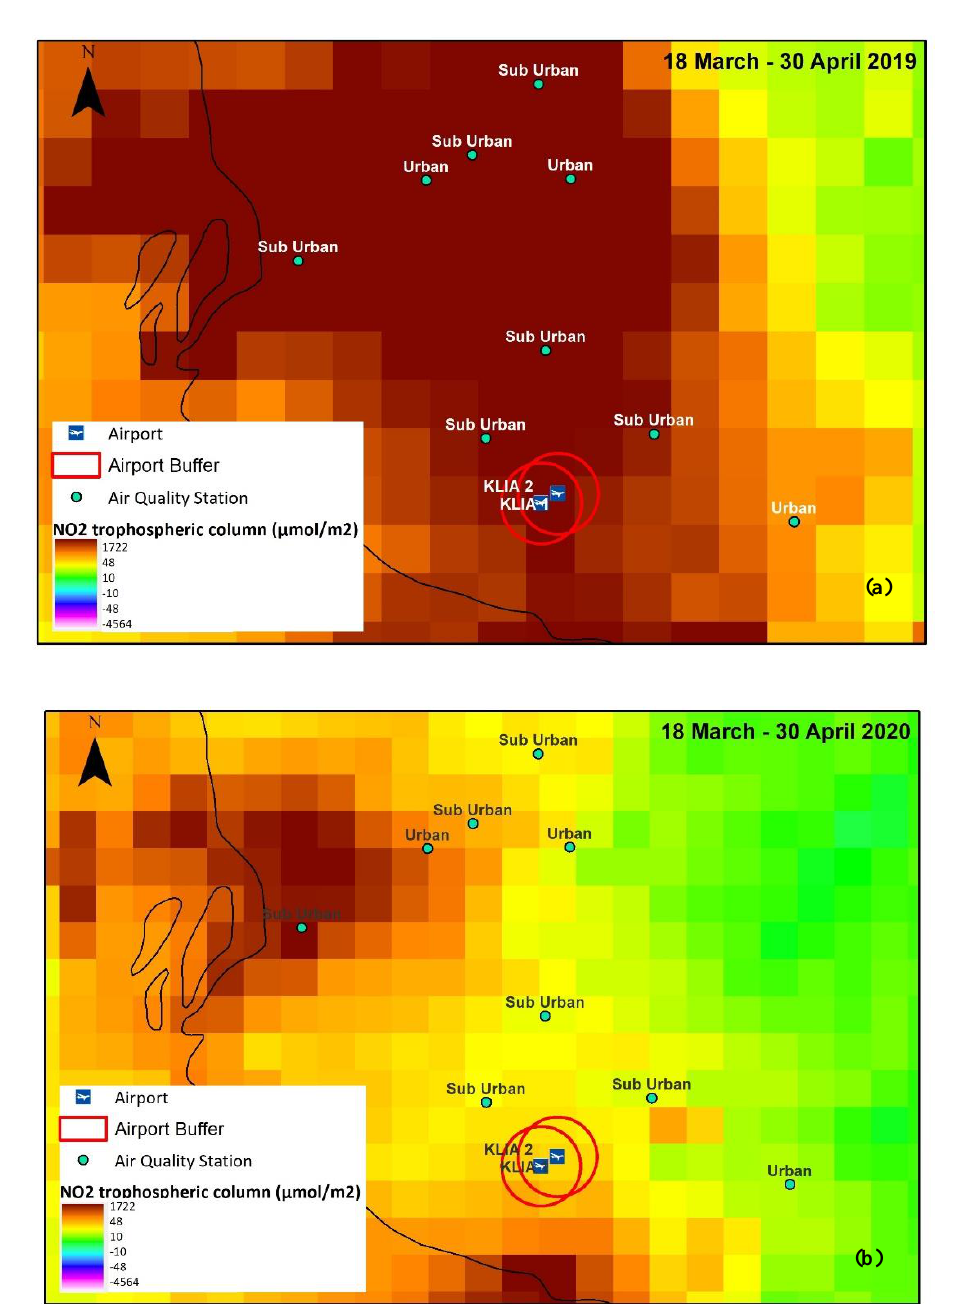
Figure 3. NO 2 variations at the airport and nearby locations in 2019 (a) and 2020 (b). Values of the pixels are NO 2 in μ mol/m